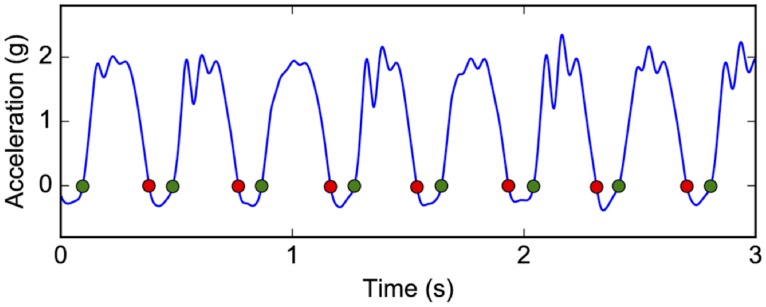
Measured vs predicted VO2max values.D = descriptive features, HR = heart rate features, ACC = accelerometer features. Points that are closer to the orange line, on which the measured VO2max equals the predicted VO2max, correspond to more accurate predictions.